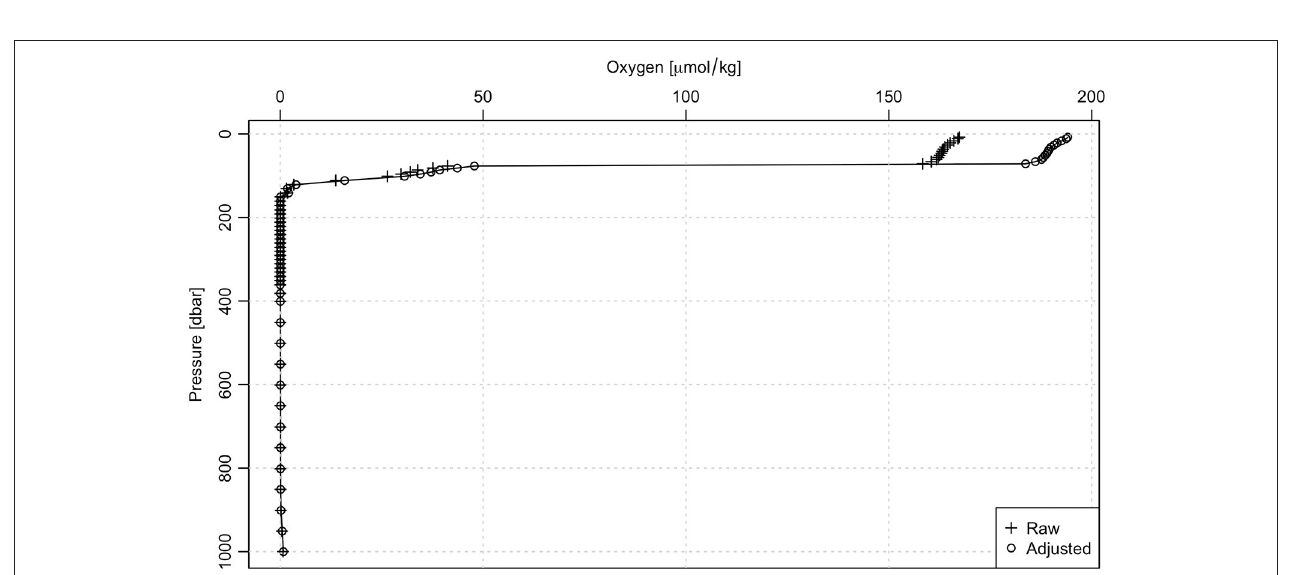
FIGURE 9 | Demonstration of the useAdjusted() function for oxygen measurements (in µ mol/kg) made during cycle 001 of Argo float 5903586.